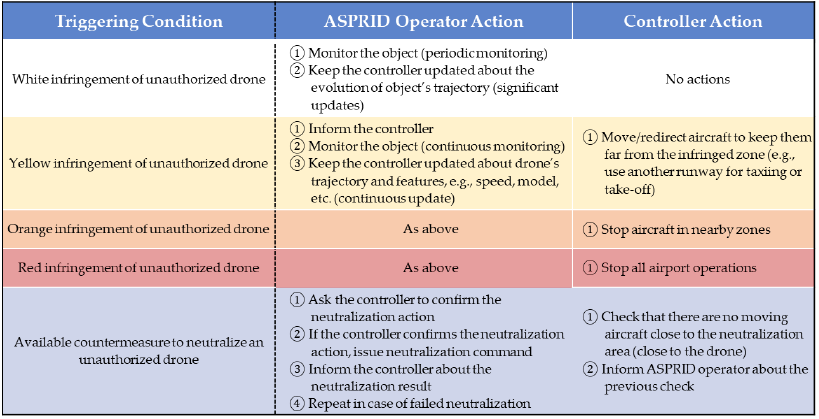
Figure 3. Tabular view of ASPRID operational procedure.